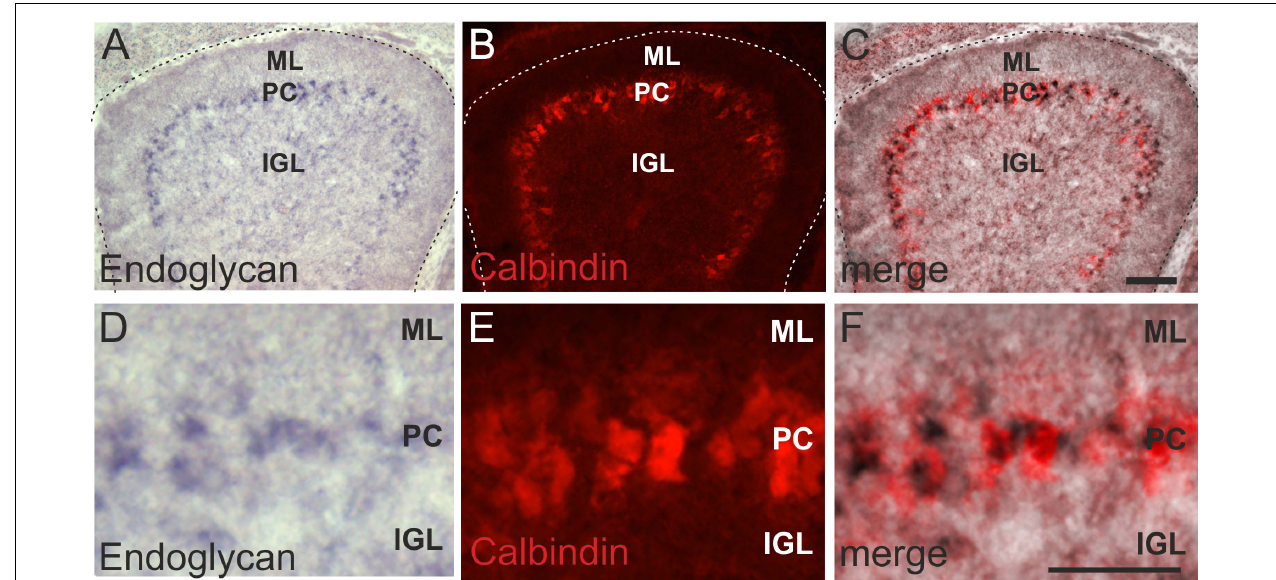
FIGURE 2 | Endoglycan is expressed in Purkinje cells. The distribution of Endoglycan mRNA during cerebellar development clearly suggested expression in Purkinje cells (A) . However, we verified this by combining the in situ hybridization with Calbindin staining, a marker for Purkinje cells (B) . Merged images shown in (C) . Higher magnification clearly reveals the overlap between in situ hybridization signal and Calbindin staining (D–F) . ML, molecular layer; PC, Purkinje cell layer; IGL, Inner granule cell layer. Bar, 100 µ m in (A–C) , 50 µ m in (D–F)